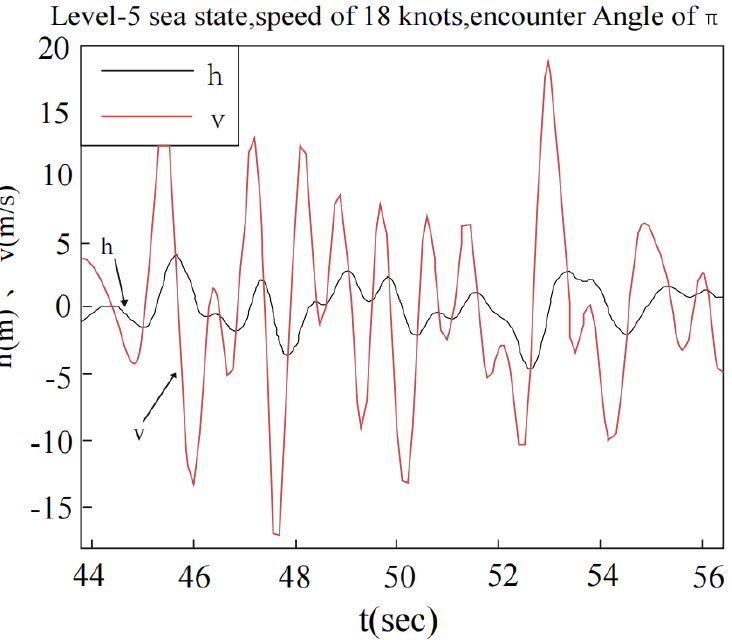
Figure 20. The curve of the landing point height and its change rate under level-5 sea state, speed V = 18 Kn , encounter angle β = π .